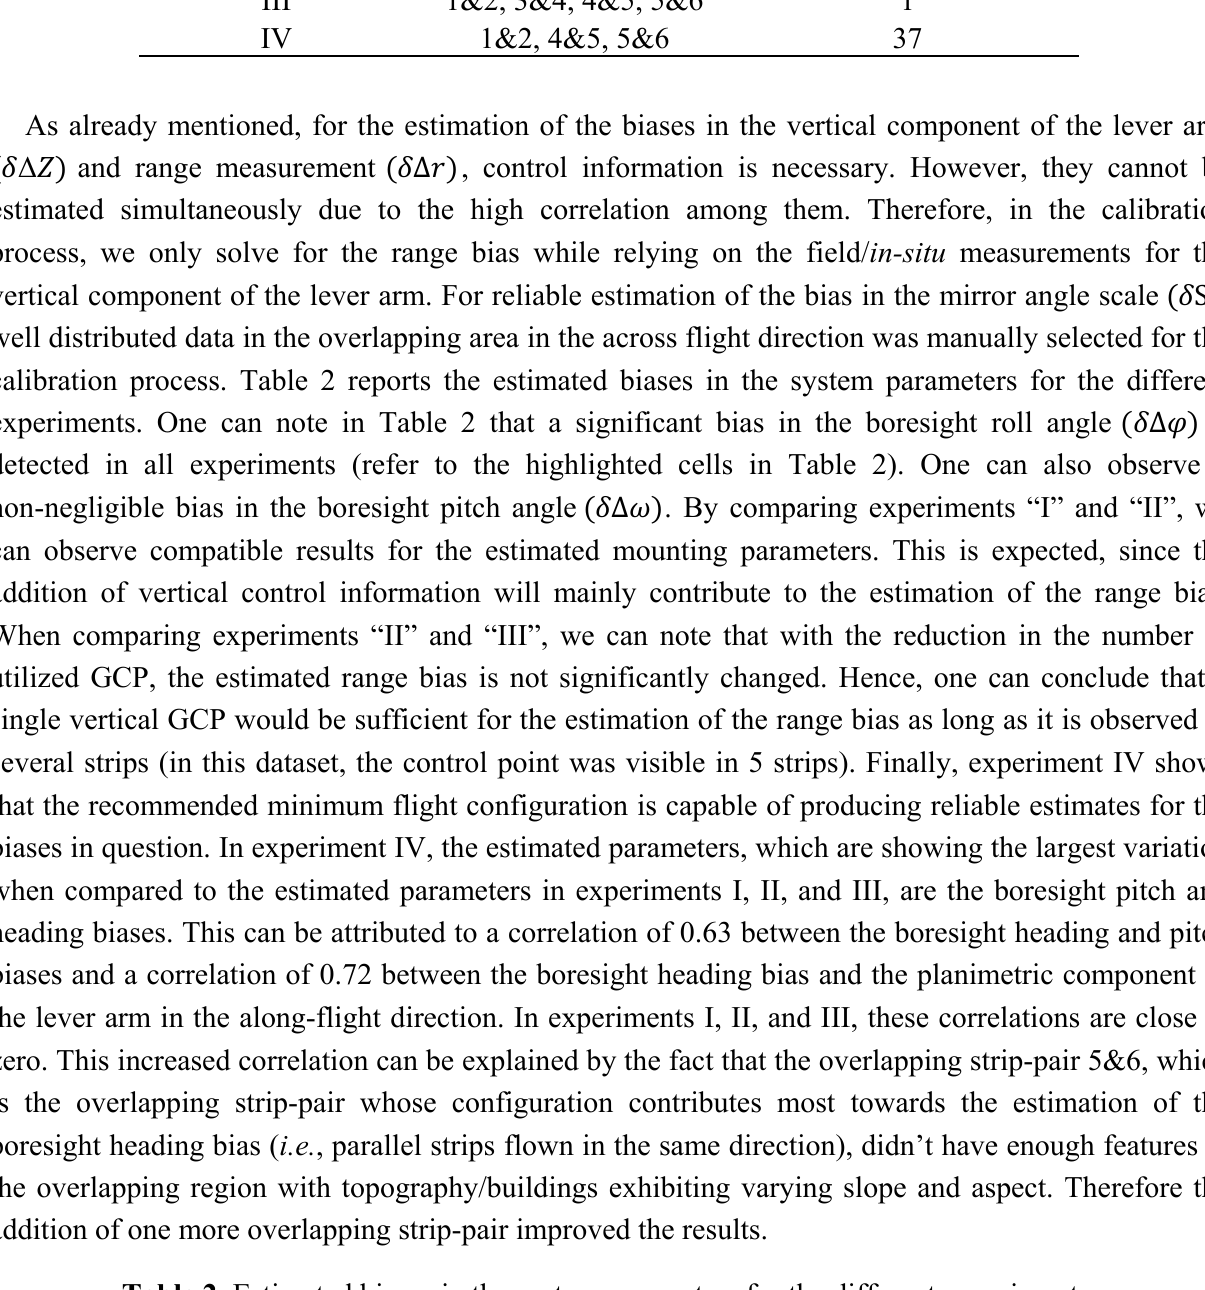
Table 2. Estimated biases in the system parameters for the different